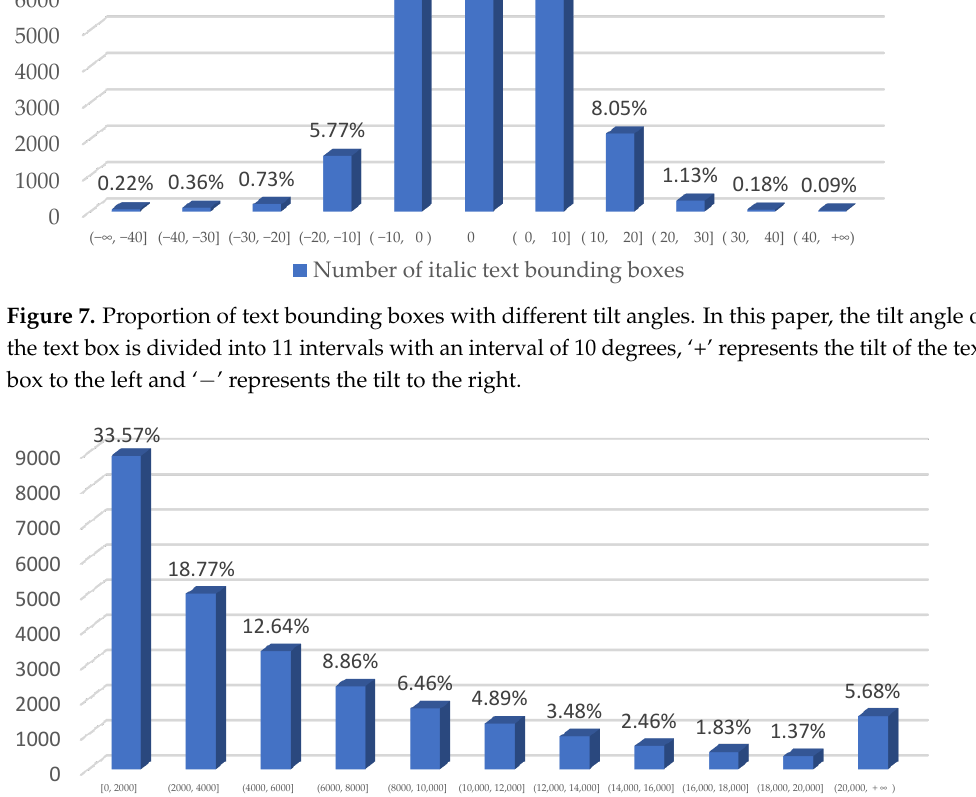
Figure 8. Proportion of text bounding boxes with different text area. In this paper, the area value of pixel level in label text box is used to reflect the size of text scale. The pixel area of text box is divided into 11 intervals with an interval of 2000 square pixels for quantitative statistics. The area unit is pixel 2 .